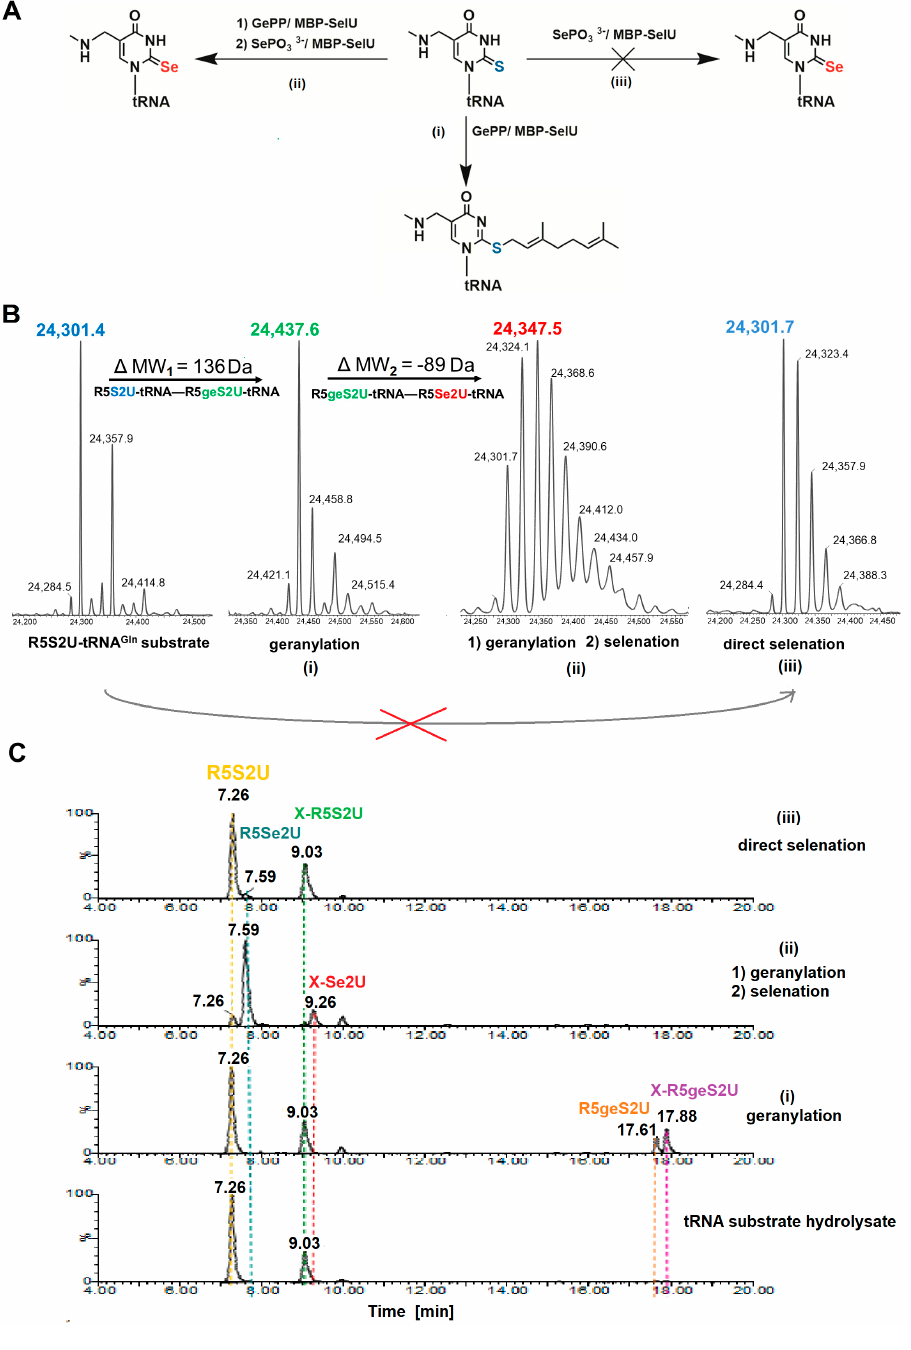
Figure 6. SelU synthase catalyzes the conversion of bacterial R5S2U-tRNA into R5Se2U-tRNA via the R5geS2U-tRNA intermediate product: ( A ) the sequence of reactions to which the tRNA Gln was subjected: (i) geranylation, (ii) geranylation and subsequent selenation of the resulting product; and (iii) direct selenation; ( B ) UPLC-PDA-ESI(-)-MS analysis of the resulting full-length tRNA Gln reaction products; ( C ) UPLC-PDA-ESI(-)-HRMS analysis of the nucleoside composition of tRNA Lys subjected to geranylation and selenation reactions followed by nucleolytic hydrolysis and dephosphorylation.